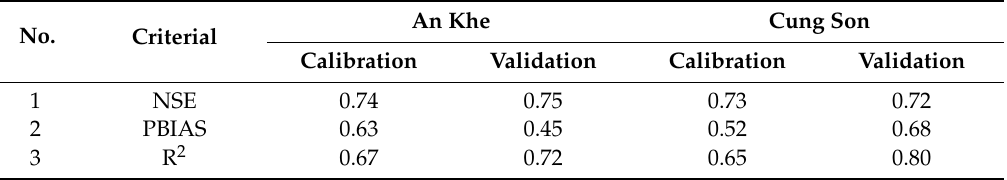
Table 7. The results of the calibration and validation of the SWAT